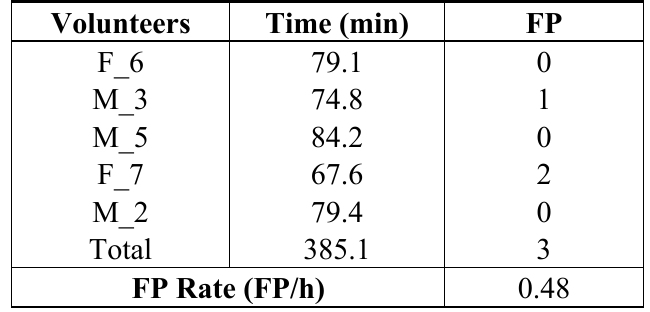
Table 6. The FP number for the subjects of Table 1 Set 1 in continuous unscripted ADL without falling activities in the experiment.